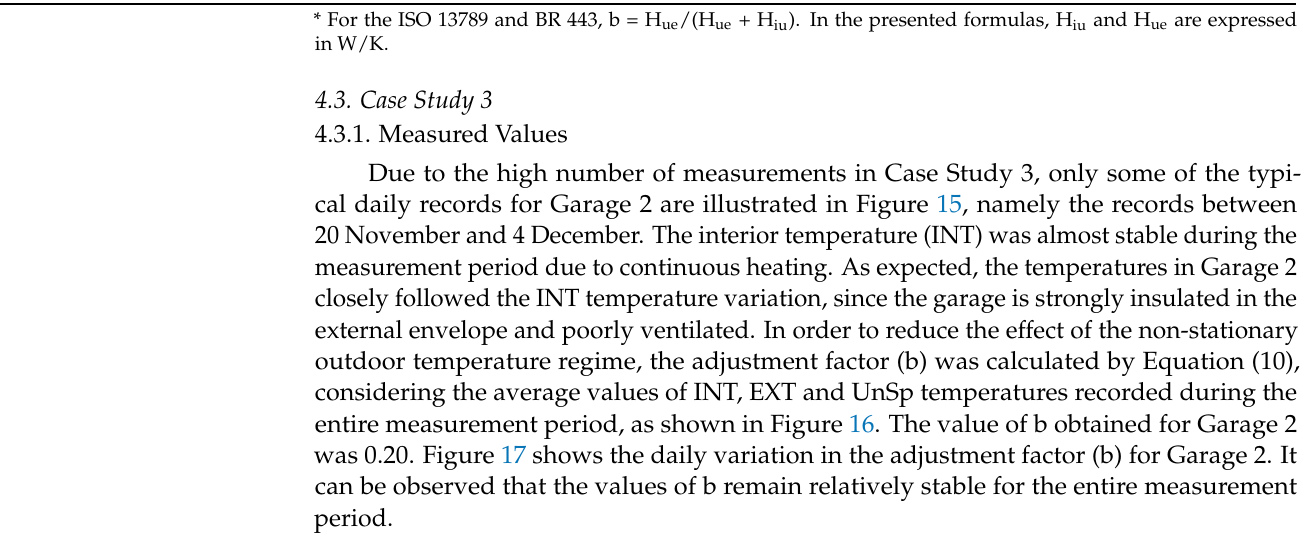
Table 6: Private garage Table 7: All components sealed, without ventilation openings (f) Tables 8 and 9: All components sealed, without ventilation openings (Case 1) Table 10b: A i /A e = 0.57; INT to UnSp (not insulated) and UnSp to EXT (not insulated) Table 11: Garage (U v ,ue = 3) Table 12: Unheated Space with external doors and windows and at least two external UNI/TS walls